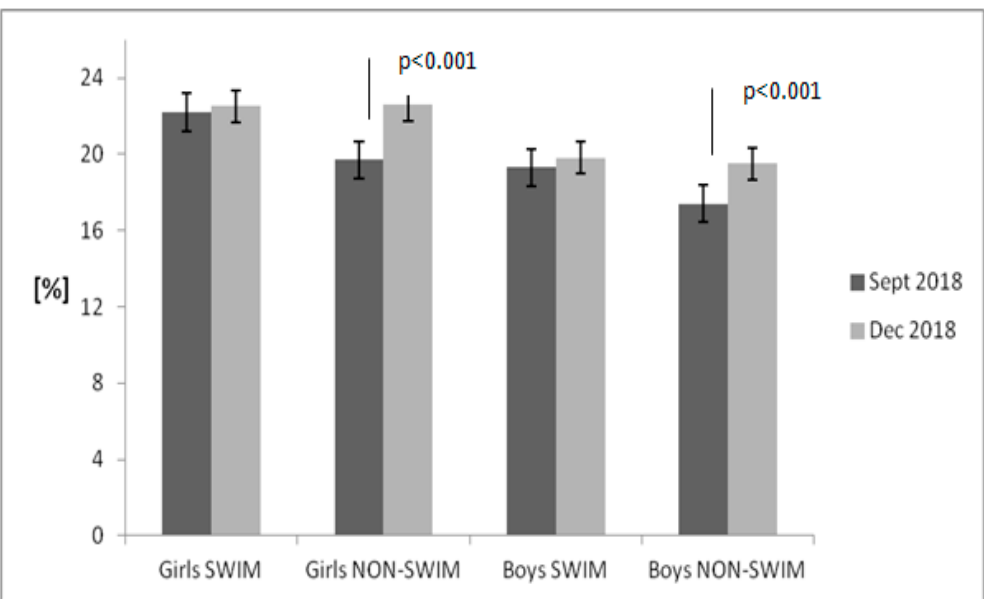
Figure 4. Body fat percentage changes in the examined groups of children. Data are presented as mean value and standard error. The non-swimmers group consisted of children participating in team sports (soccer, basketball), athletics, martial arts and dance.